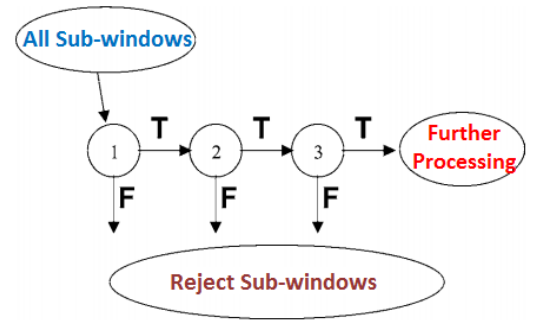
Figure 11. The Cascaded classifier.